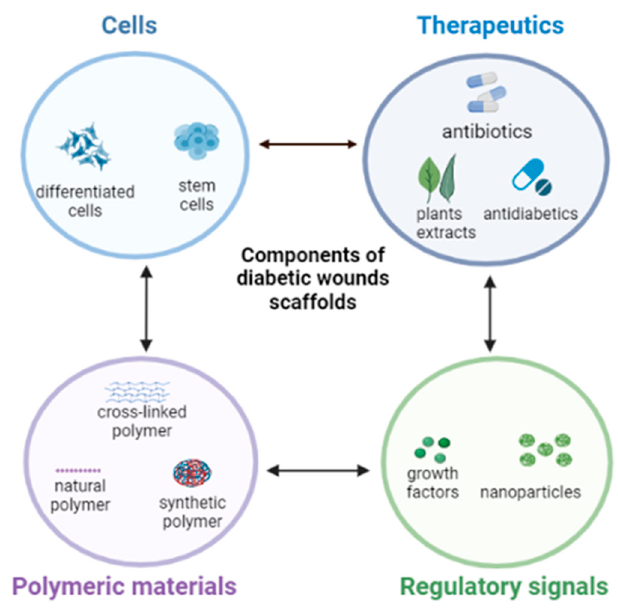
Figure 1. Typical bioactive components of nanofibrous scaffolds for diabetic wound healing. Create in BioRender.com.